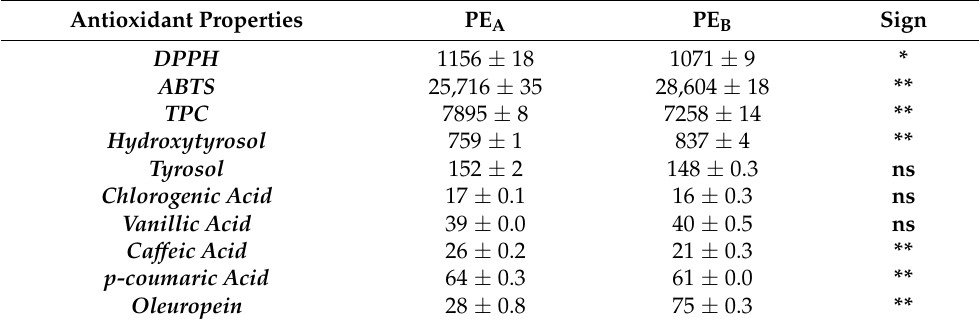
Table 1. Antioxidant parameters and individual Phenolic Compounds of phenolic extracts. Antioxidant